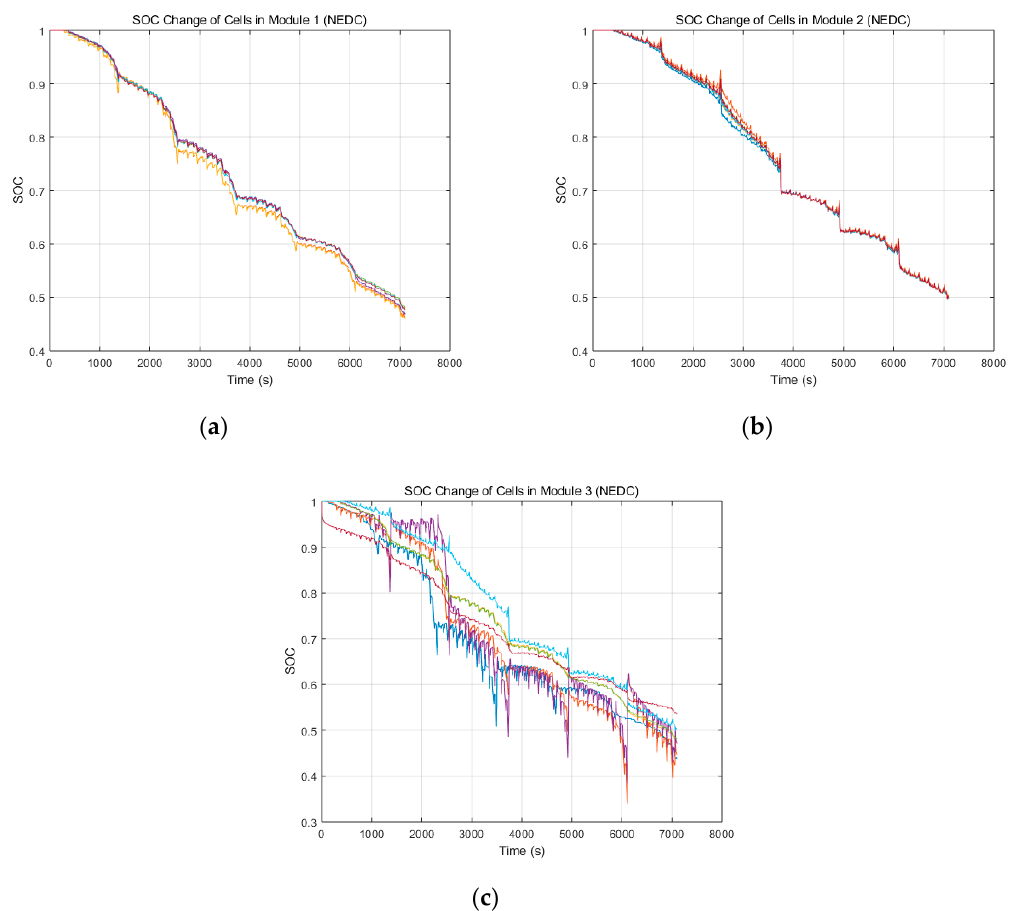
Figure 10. State of charge (SOC) curve of cells in modules: ( a ) Module 1, ( b ) Module 2, ( c ) Module 3.